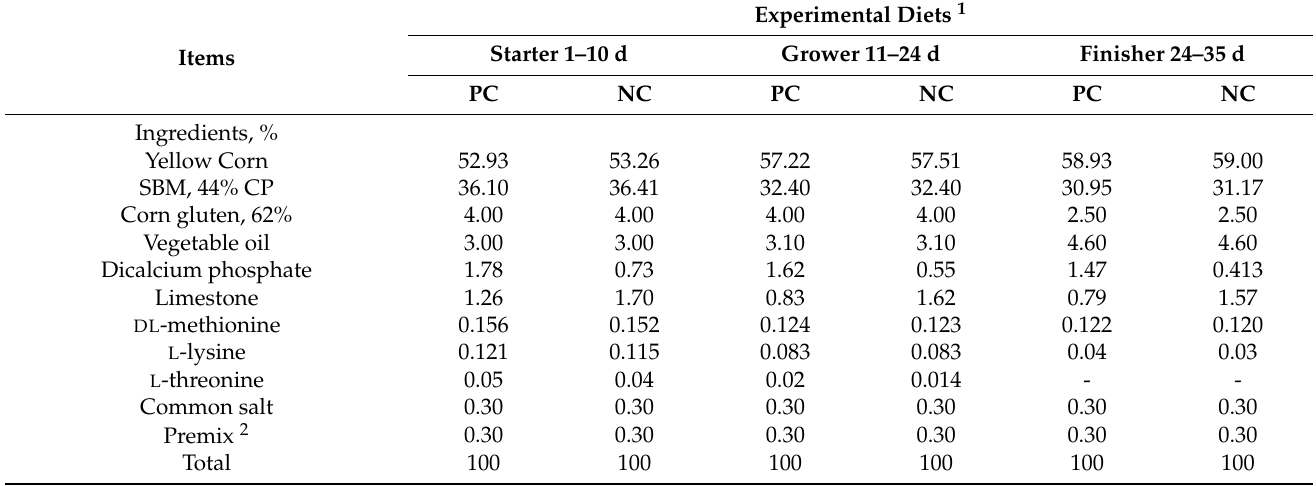
Table 1. Composition and analysis of the experimental